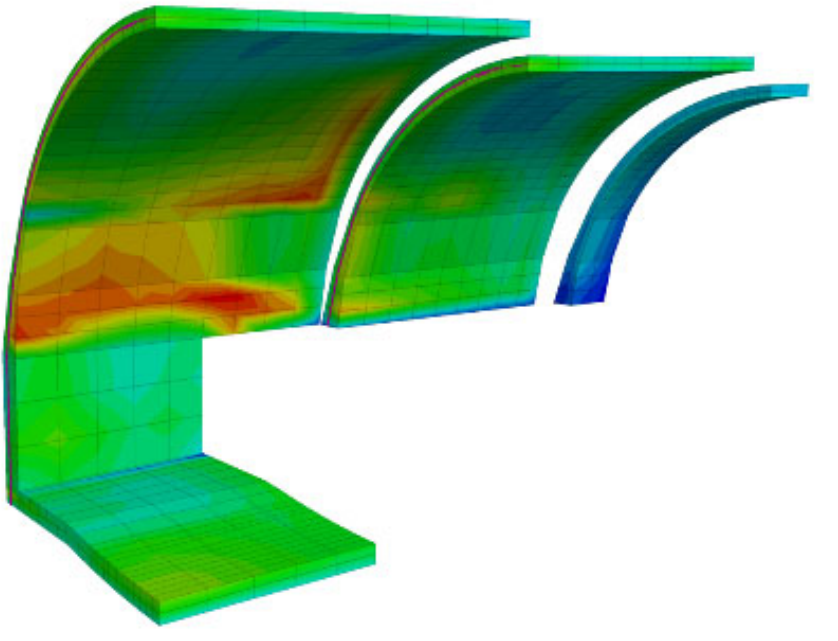
Figure 13. Minor principal stress contours (in N/m 2 ) in concrete elements [12].